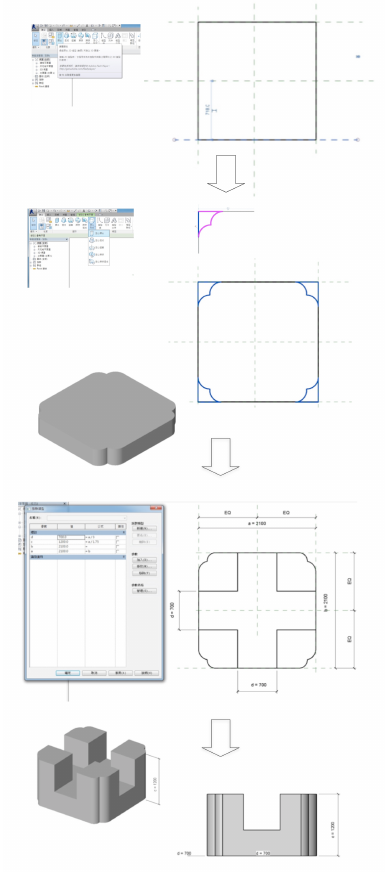
Figure 9. The system of parametric modeling process